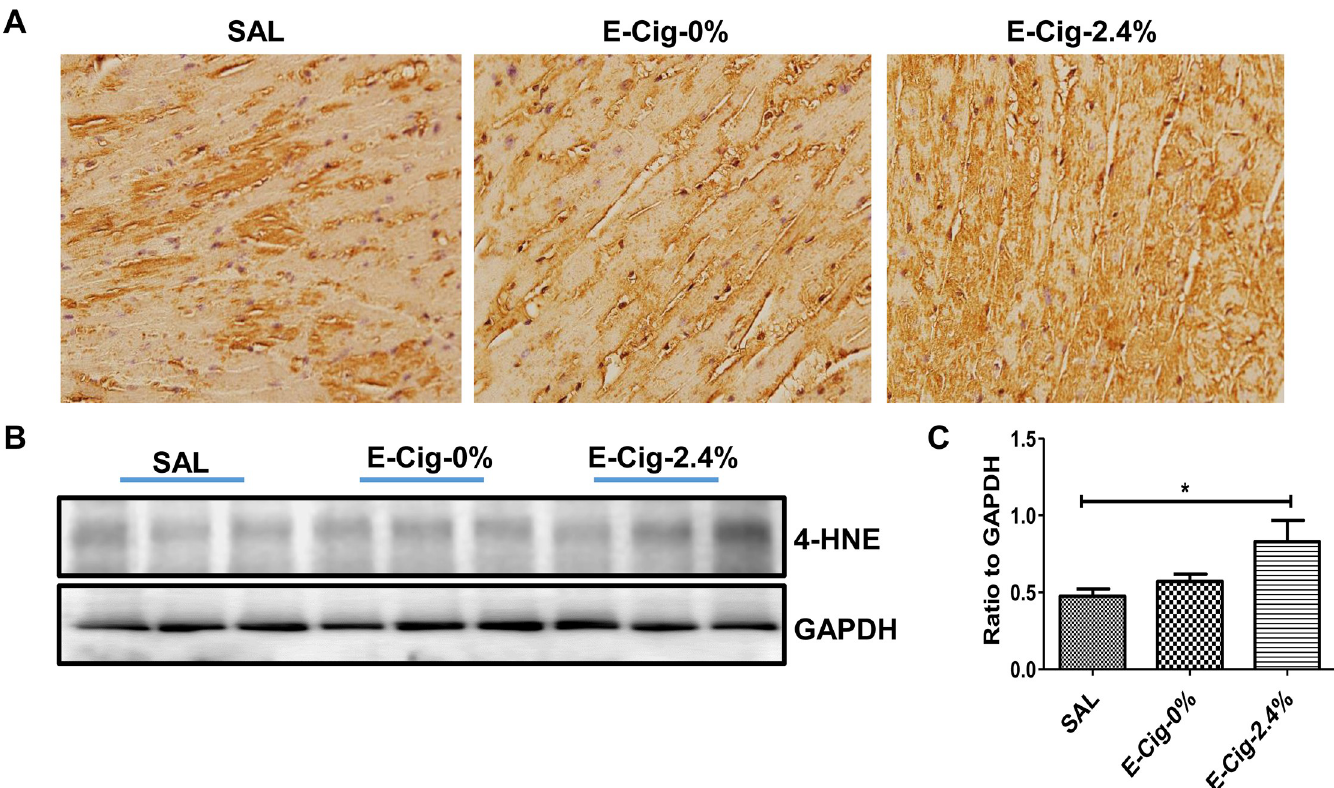
Fig 4. E-cigarettes (2.4% nicotine) plus HFD inactivates AMPK. ( A ) Western blot analysis of ventricular expression of phospho(p)-AMPK, total AMPK, phospho (p)- ACC, total ACC shows that mice on an HFD exposed to e-cigarette have markedly decreased p-AMPK and p-ACC levels compared with mice on an HFD exposed to saline or e-cigarette (0% nicotine) aerosol. ( B, C ) Quantitation of band intensities. GAPDH in the immunoblot is shown as a loading control. P < 0.05. Values are given as means ± SE of 5 mice per group. � P < 0.05.